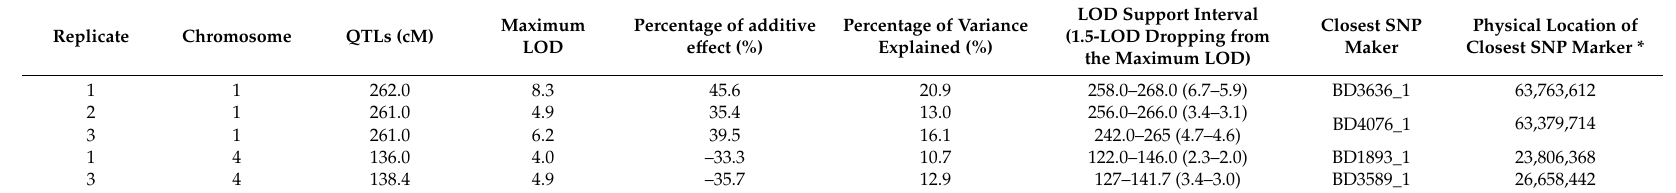
Table 2. Summary of mQTLs related to chrysanthemin